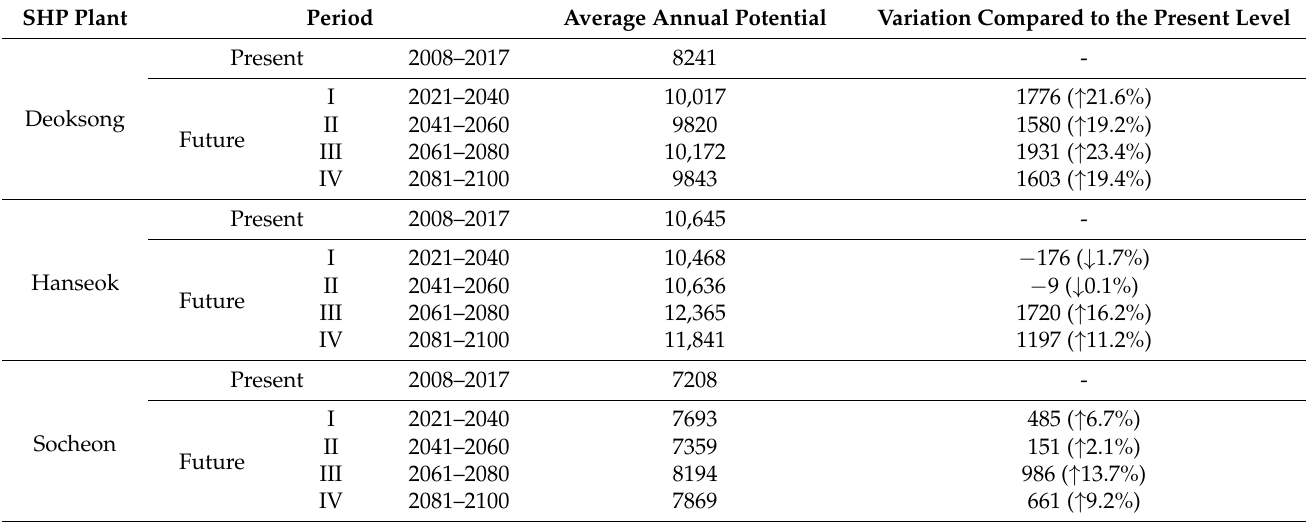
Table 9. Analysis of the variability of annual SHP potential by SHP plant [unit: MWh]. SHP